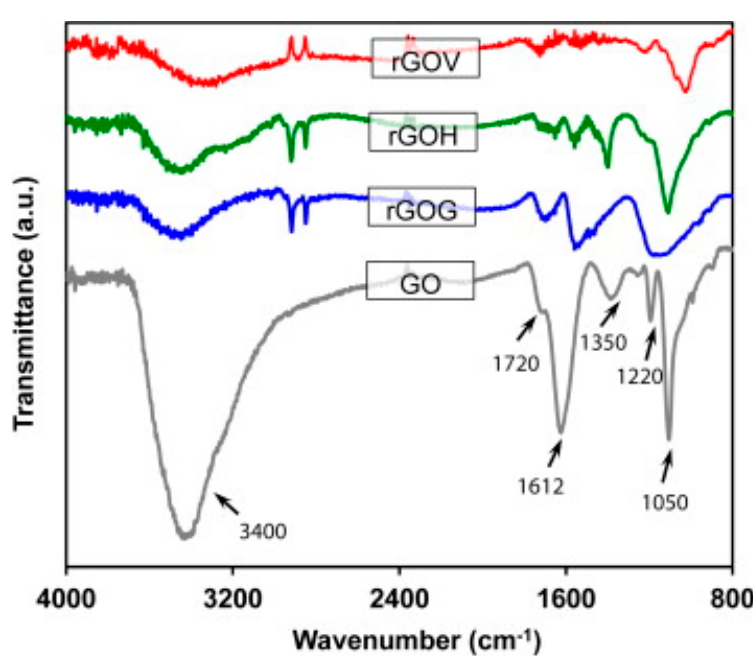
Figure 24. FT-IR spectra for GO and G prepared by reduction of GO using glucose (GOG), hydrazine (GOH) and ascorbic acid (GOV). Reprinted with permission from reference [158]. Copyright 2014